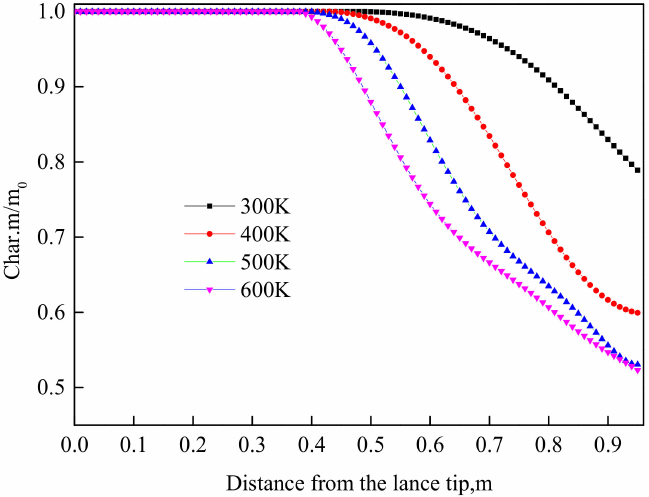
Figure 6. E ff ect of oxygen temperature on m / m 0 of